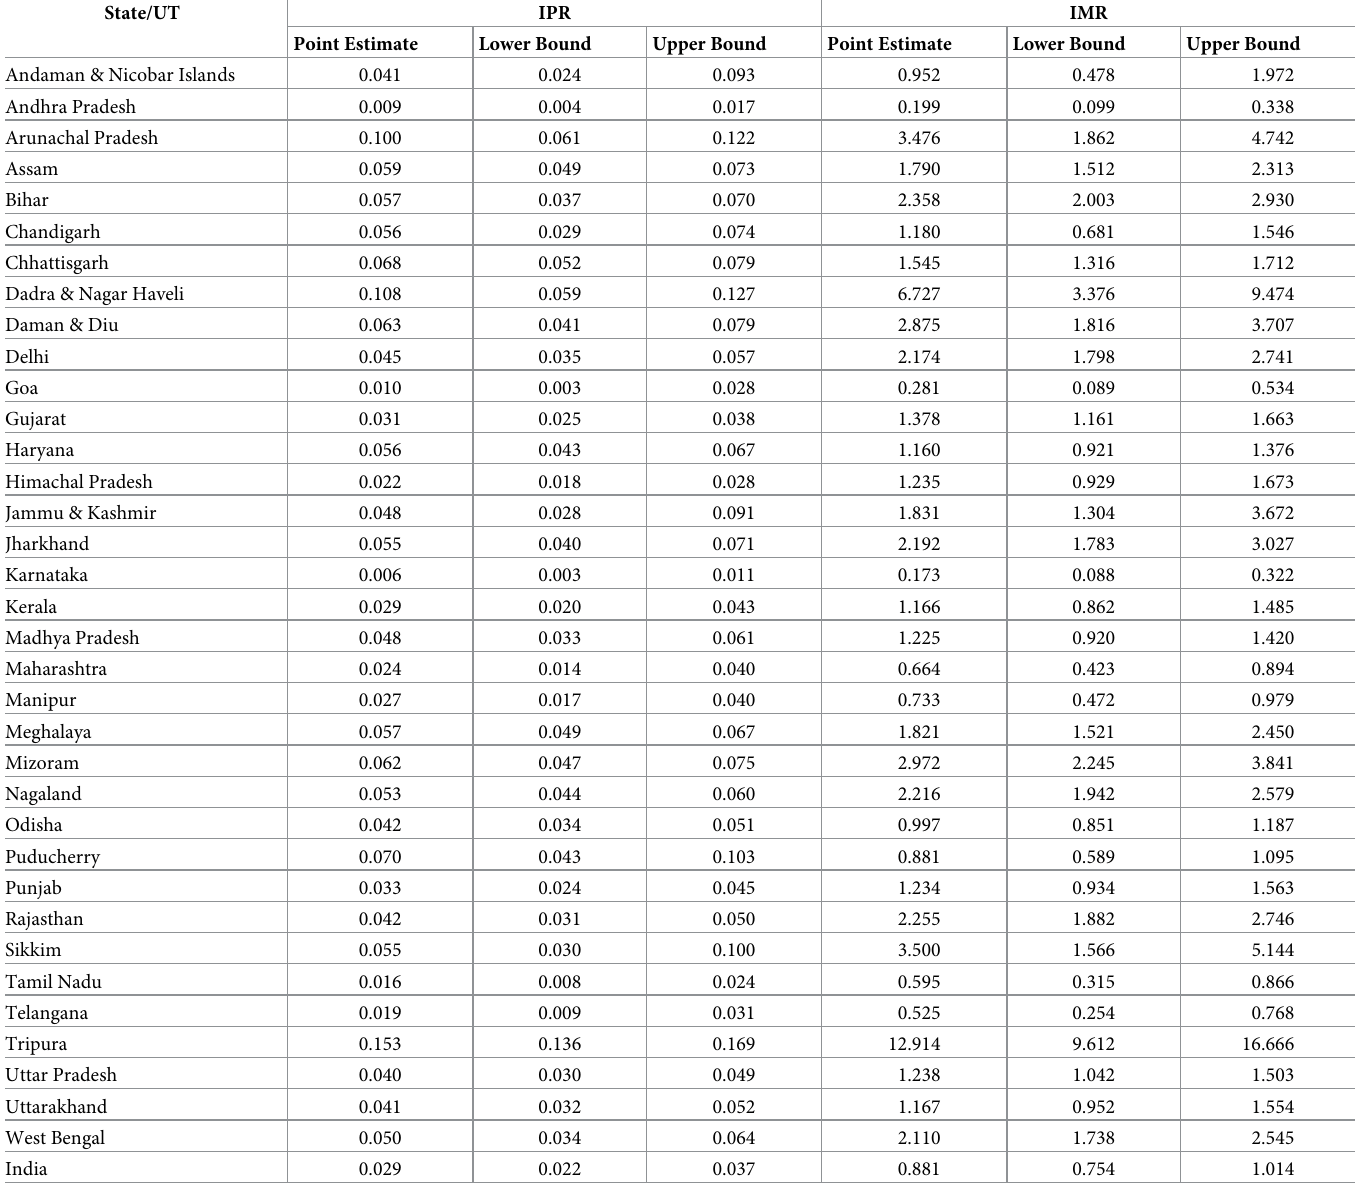
Table 1. Incidence-prevalence ratio and incidence-mortality ratio (with uncertainty bounds) by States/UTs in India, 2019.